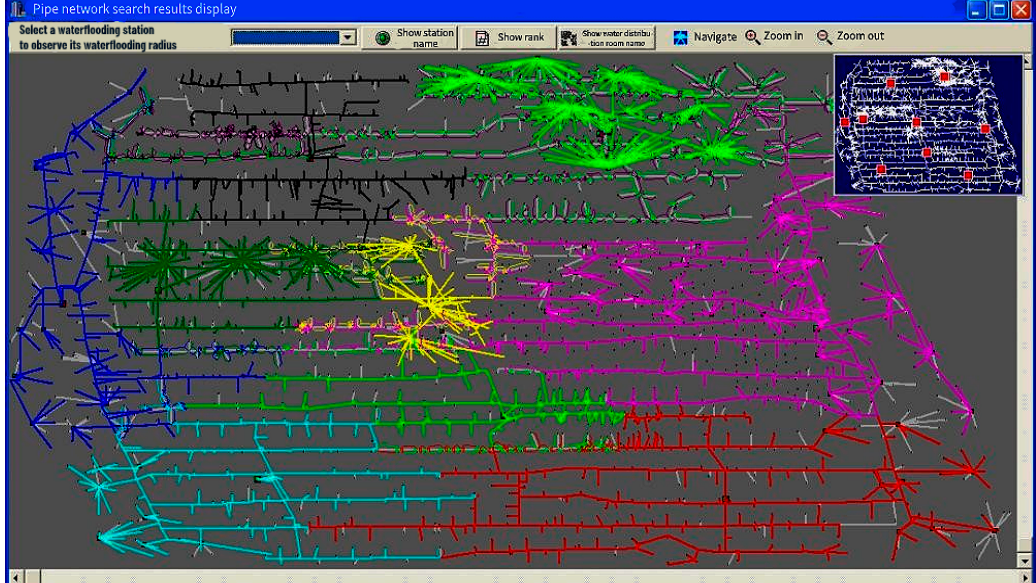
Figure 4. The waterflooding radius of the system.